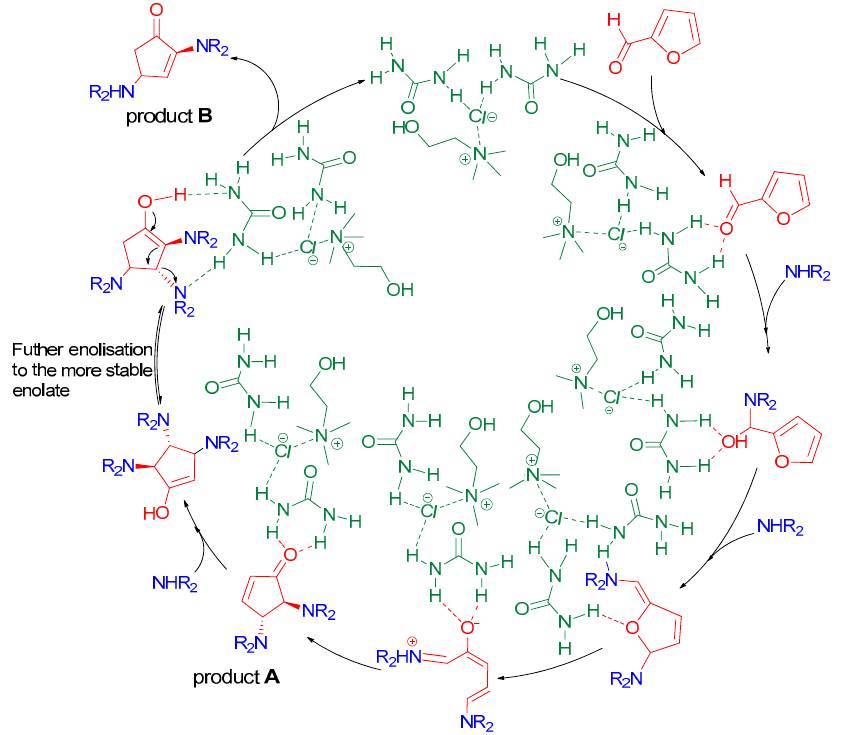
Figure 3. Proposed mechanism of the reaction in DES.